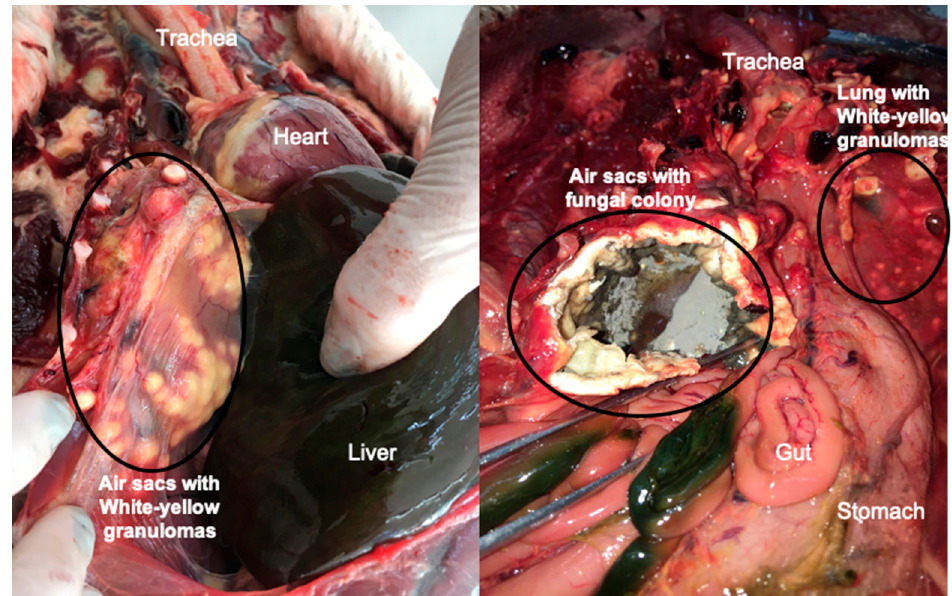
Figure 2. Common lesions of pulmonary aspergillosis found in avian species A: White-yellow granulomas on air sac membranes from a Magellanic penguin that died during rehabilitation at the Center of Rehabilitation of Marine Animals, Brazil, B: Growth of fungal colonies of Aspergillus fumigatus on air sac membranes with evidence of substantial sporulation, from a free-ranging Magellanic penguin, found dead on Cassino beach, Rio Grande, Brazil.